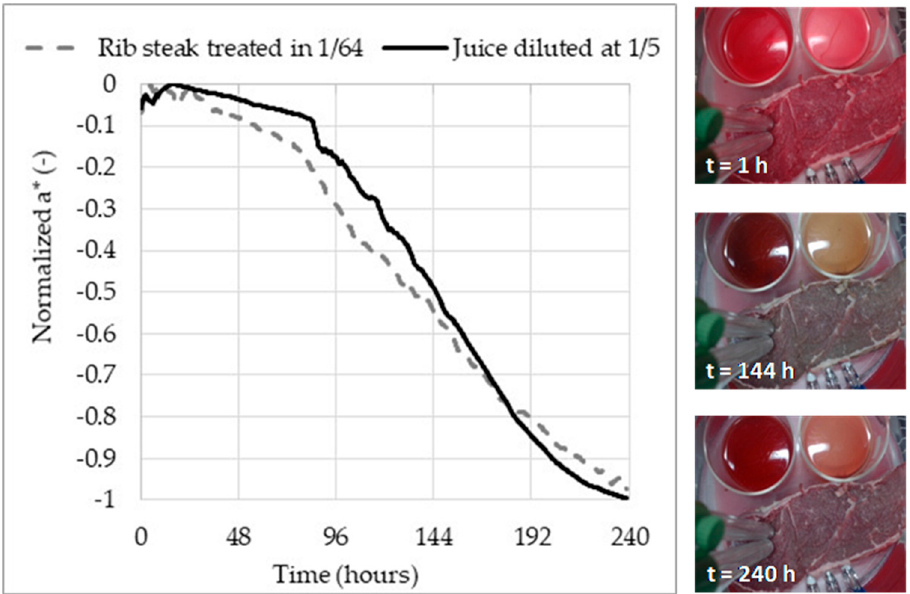
Figure 6. Monitoring of the color transfer (normalized values of a*) of a rib steak, in grey dashed line, and its associated juice (50 mL pure on the left and 50 mL diluted 1/5 on the right), in black solid line, at 4 °C as a function of time, and the associated photos showing their color transfers at t = 1 h, t = 144 h, t = 240 h.